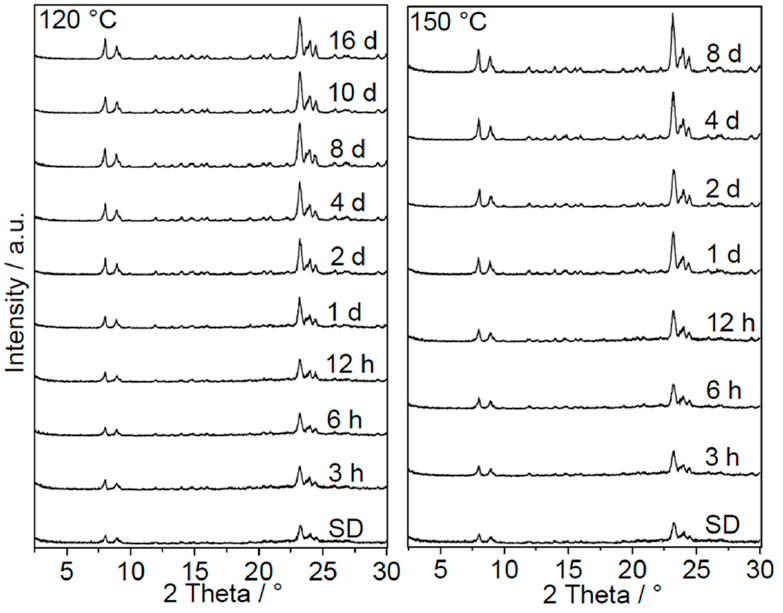
Figure 7. XRD patterns of the spray-dried particles and dried samples collected after SAC at 120 °C ( left ) and 150 °C ( right ), showing the development of apparent MFI crystallinity as a function of SAC time.